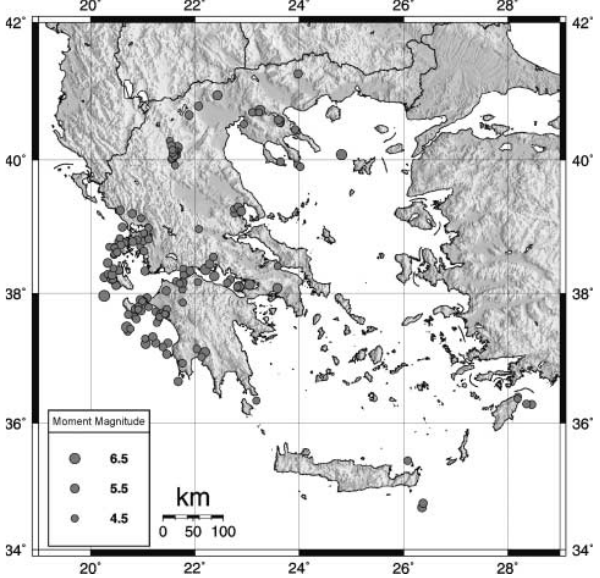
Fig. 1. Epicentral distribution of earthquakes used in the present analysis.